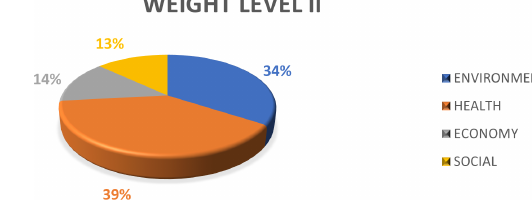
Figure 1: Hierarchical decomposition of AHP